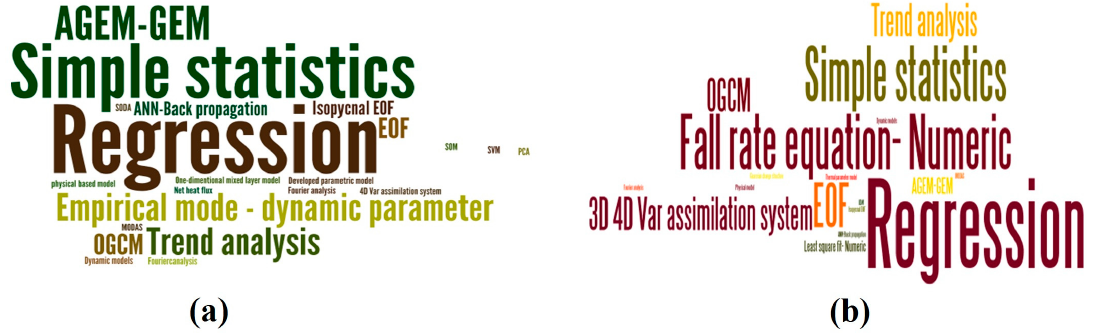
Figure 5. ( a ) A tag cloud of the literature methods related to ocean/sea subsurface water temperature in the remote sensing scope and ( b ) the non-remote sensing scope, where a larger font denotes a higher frequency.